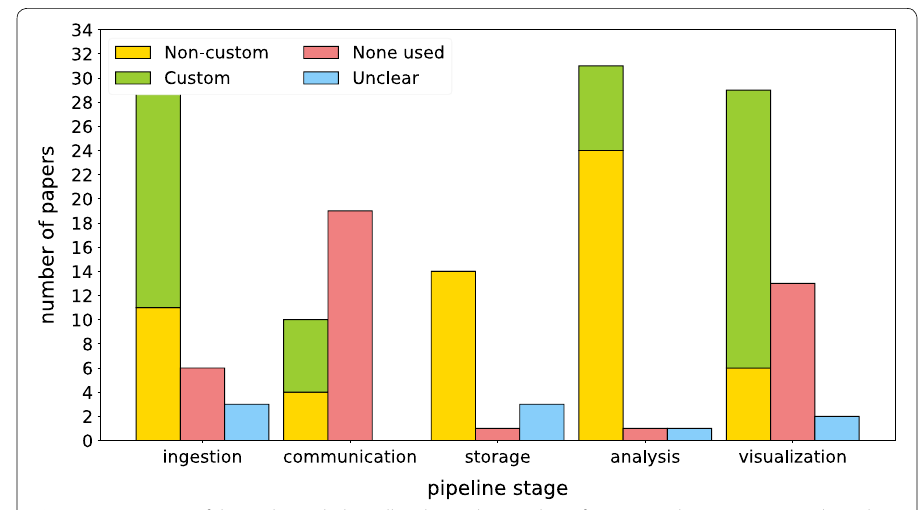
Fig. 6 An overview of the tools used. The yellow bar is the number of unique and non‑custom made tools (e.g., NiFi, Kafka). The green bar is the number of custom tools (e.g., ad hoc scripts/applications). The red bar shows the number of pipelines that did not use any tool for that specific stage. The blue bar counts the number of cases of uncertainty in the results (e.g., a paper includes a tool in its figure of the data analysis pipeline but then does not mention it